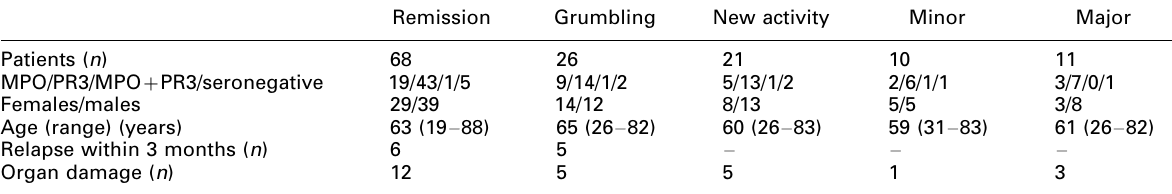
Table 1. Patient